Question: Write a caption explaining this figure to a reader.
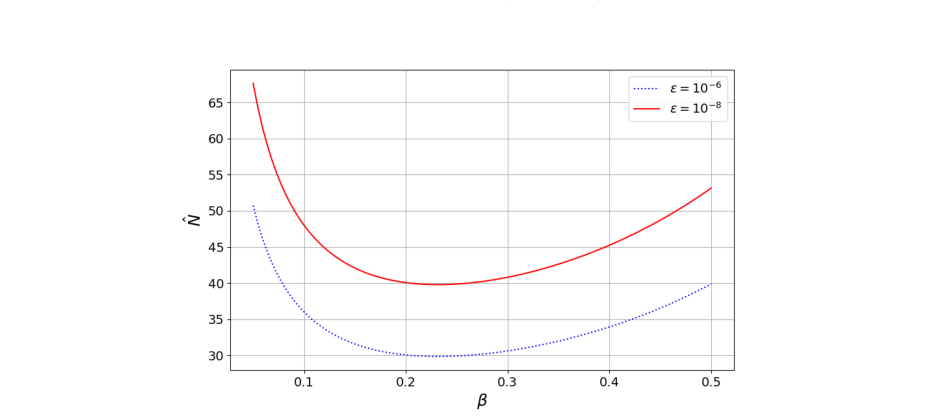
Answer: Upper bound ˆN on the number of box iterations.